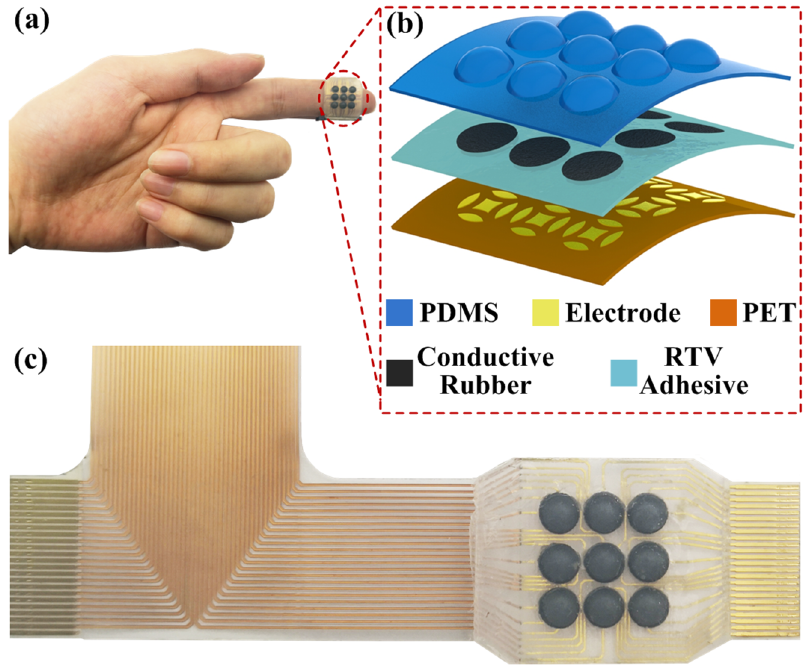
Figure 1. ( a ) and ( b ) Structure of the flexible tactile sensor array; ( c ) Fabricated tactile sensor